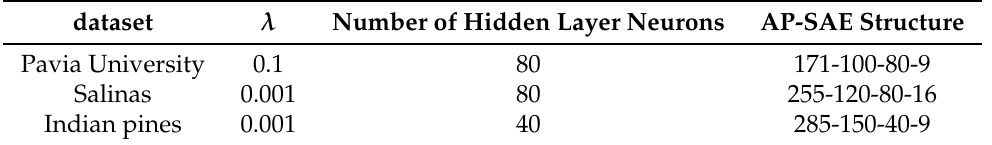
Table 2. Optimal parameter setting for different datasets.